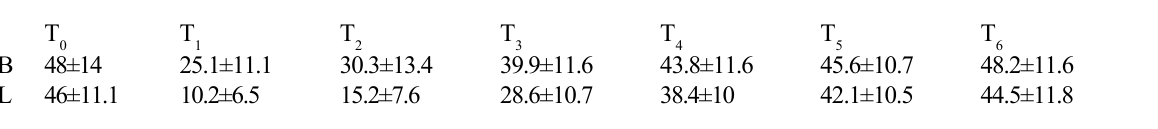
TABLE 10 - Left ventricular stroke work index g.min -1 .m